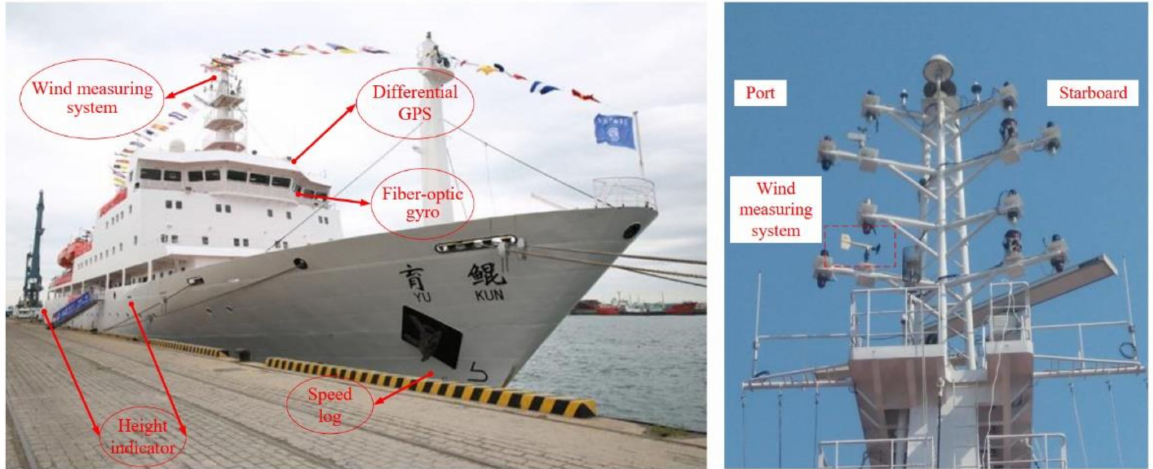
Figure 10. The measuring instruments installed onboard of Yukun